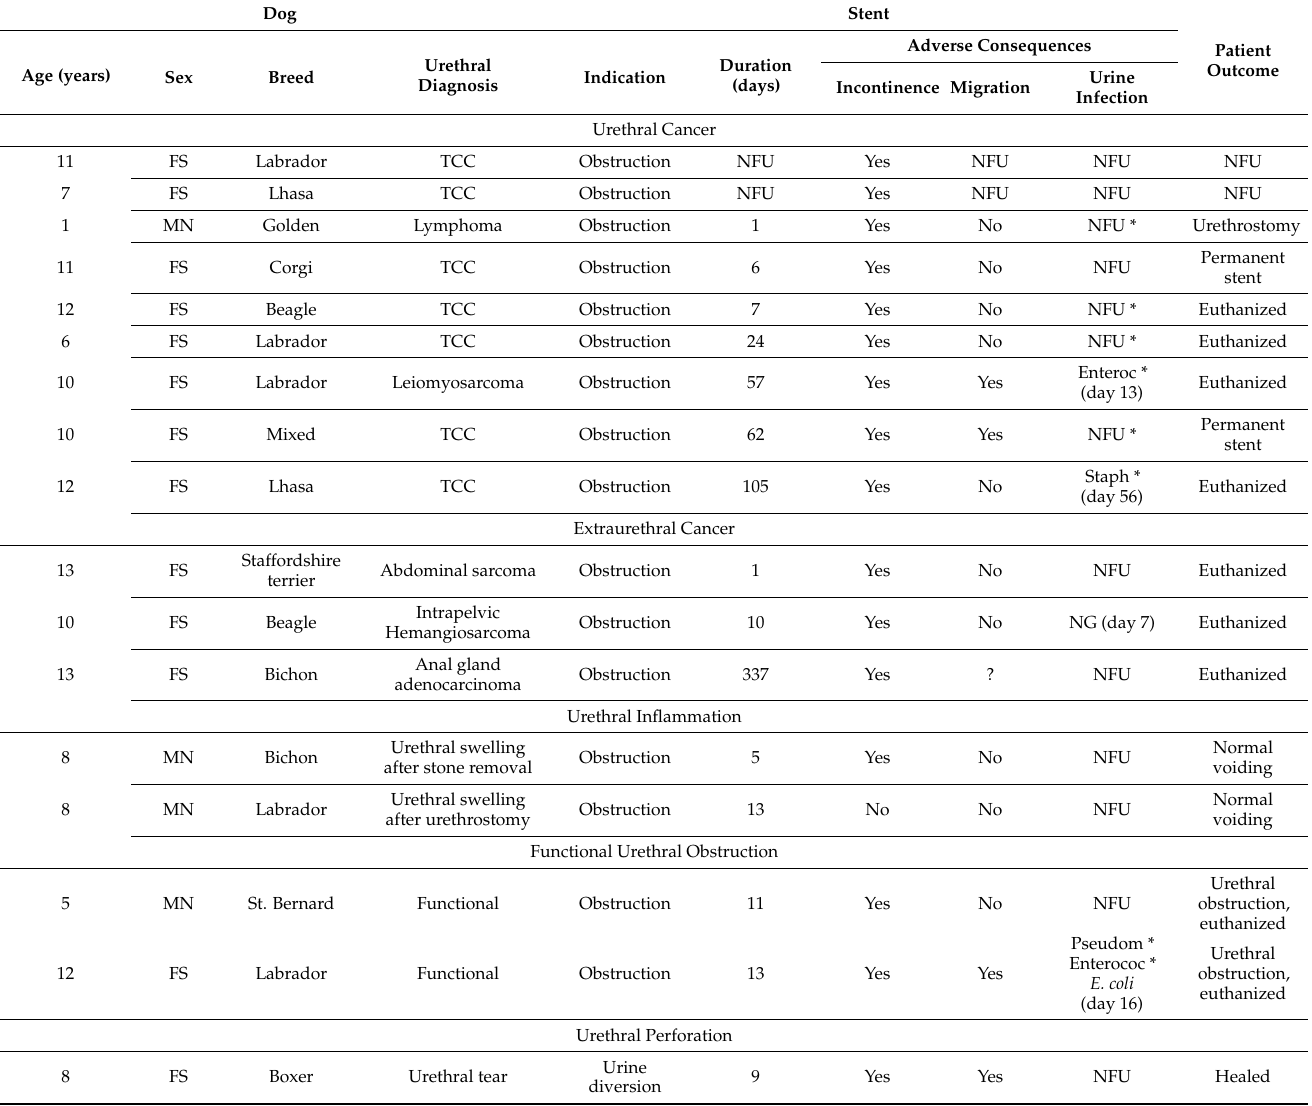
Table 1. Indication, duration, and outcomes of placing temporary urethral stents in 17 dogs with urethral cancer, extraurethral cancer, urethral inflammation, functional urethral obstruction, or a urethral